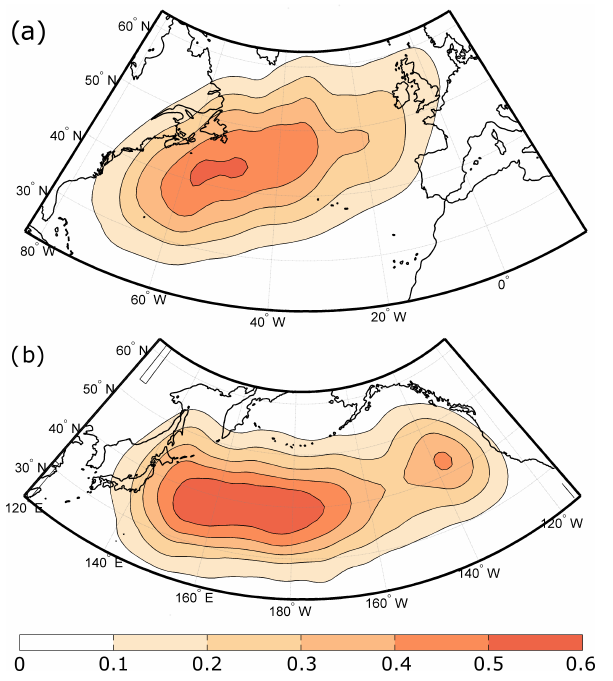
Figure 1. Spatial distribution of the location where explosive cyclo- genesis reach their minimum core pressure for (a) Atlantic Ocean and (b) Pacific Ocean. Contours correspond to the average num- ber of events per extended winter (ONDJFM) season, detected per 5 ◦ × 5 ◦ area normalized for 50 ◦ N. The spatial distribution was smoothed with a 5 ◦ averaging